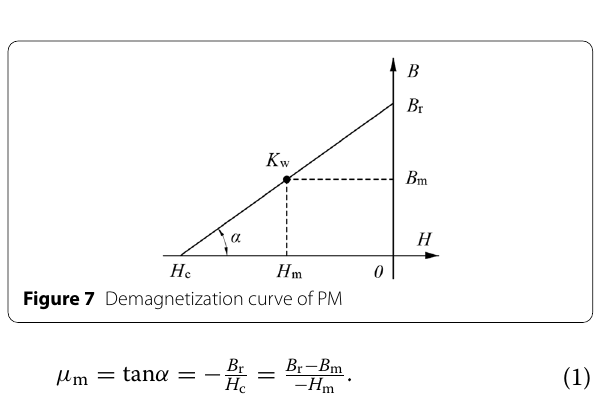
Figure 7 Demagnetization curve of